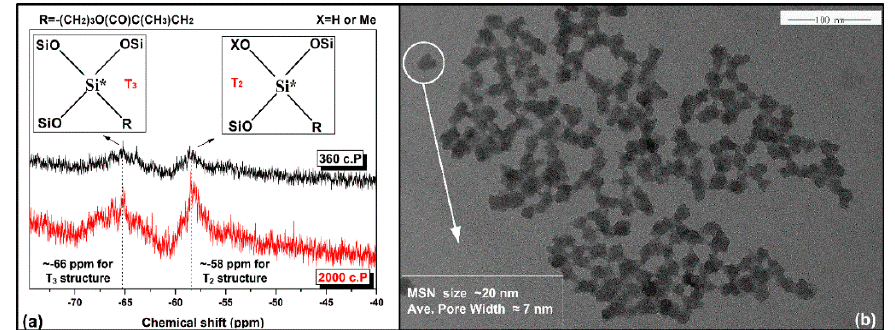
Figure 2. Structure properties of the polysiloxane sol and mesoporous silica nanoparticles (MSNs), ( a ) 29 Si liquid NMR spectra of polysiloxane sol with different polymerization degrees, ( b ) TEM image of MSNs with information from N 2 adsorption–desorption analysis.